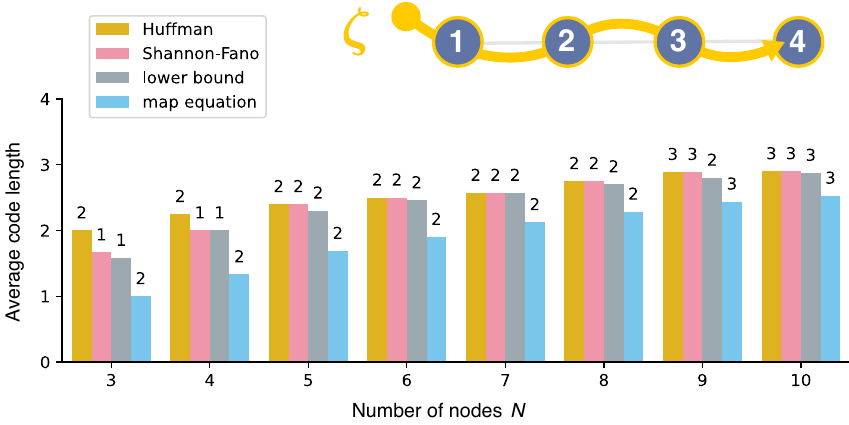
Figure 3. Average code lengths for a trajectory on a path (illustrated at the top) obtained by minimising L ( σ ; ζ ) (“Huffman”: Huffman coding, “Shannon–Fano”: Shannon–Fano coding) and L ( σ ; ζ ) (“lower bound”). The expected average code length L ( σ ) (“map equation”) based on the set of transition probabilities induced by the edges, i.e., the - -flow-model rawdir option, is also shown. The number of detected modules in each method is indicated at the top of each